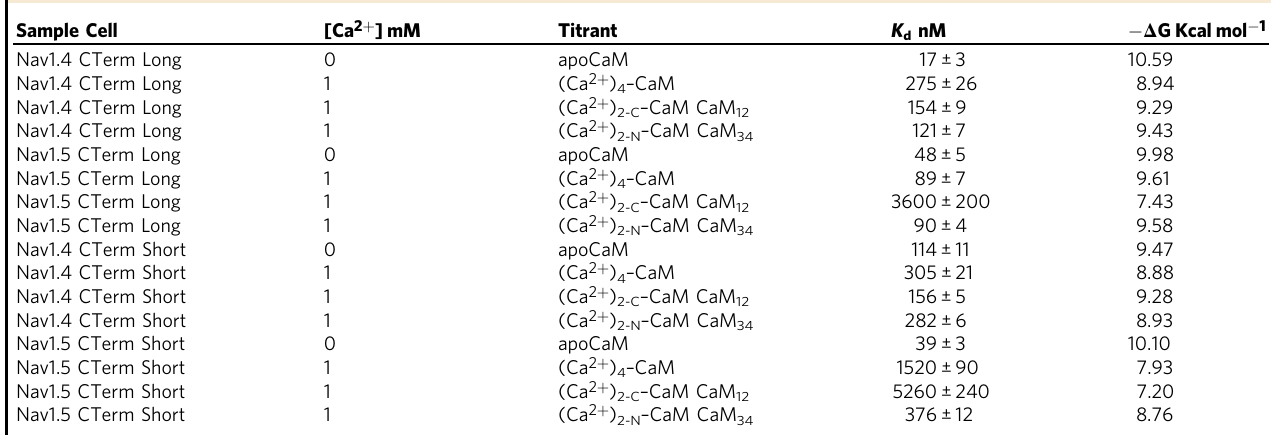
Table 2 Binding Data of CaM Species for Na V 1.4 or Na V 1.5 CTerm Sample